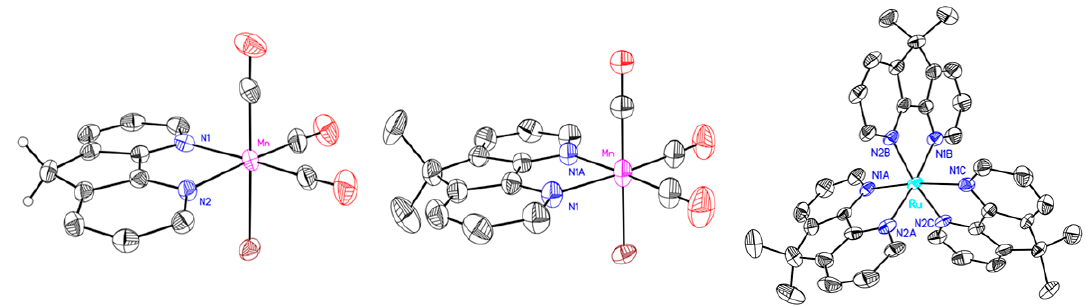
Figure 4. Solid-state structures of 2 (left), 3 (middle), and 5 (right, from structure q36k). Displacement ellipsoids are shown at 50% probability level. Hydrogen atoms (except H14A and H14B for 2 ) and outer sphere hexafluorophosphate counteranions and disordered co-crystallized solvent (for 5 , from structure q36k) are omitted for clarity.